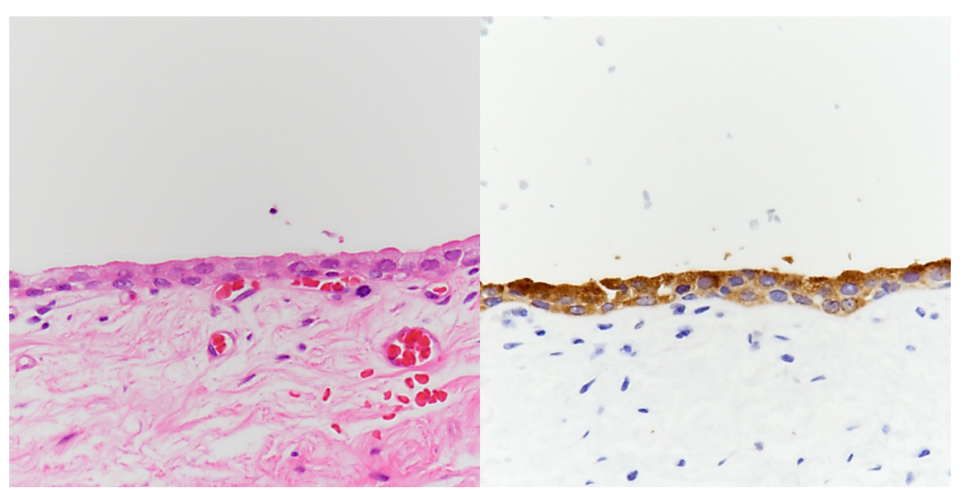
Figure 2. Histologically, the giant multilocular prostatic cystadenoma is lined by flat to cuboidal ep- ithelium set in the hypocellular fibrous stroma. No cytologic atypia is identified (left, H-E, × 400). The epithelial lining displays PSA immunopositivity, confirming its prostatic origin (right, PSA, × 400). There were no complications postoperatively, and the patient was discharged on postoperative day 5. At the 12-month follow-up, computed tomography (CT) revealed the recurred mass in the previous surgical field, about 8.0 × 6.5 × 9.0 cm-sized, lobulated cystic lesion with multiple thin septa in the left prostate without solid component (Figure